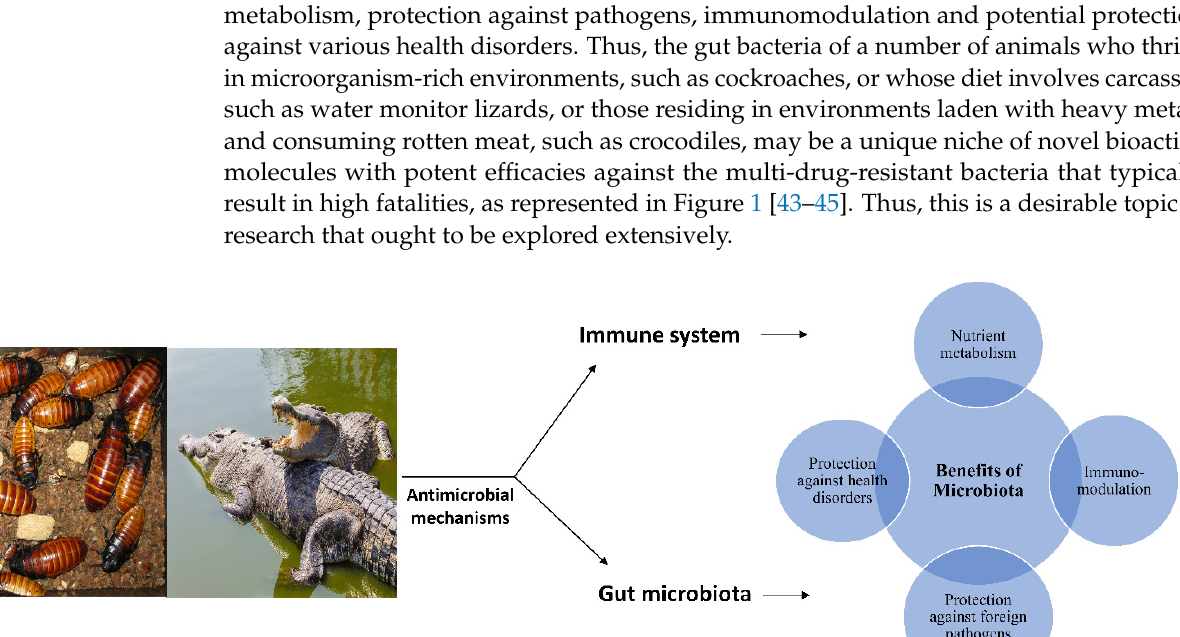
Table 1. Selected gut bacteria of reported animals and their antibacterial properties. Animal